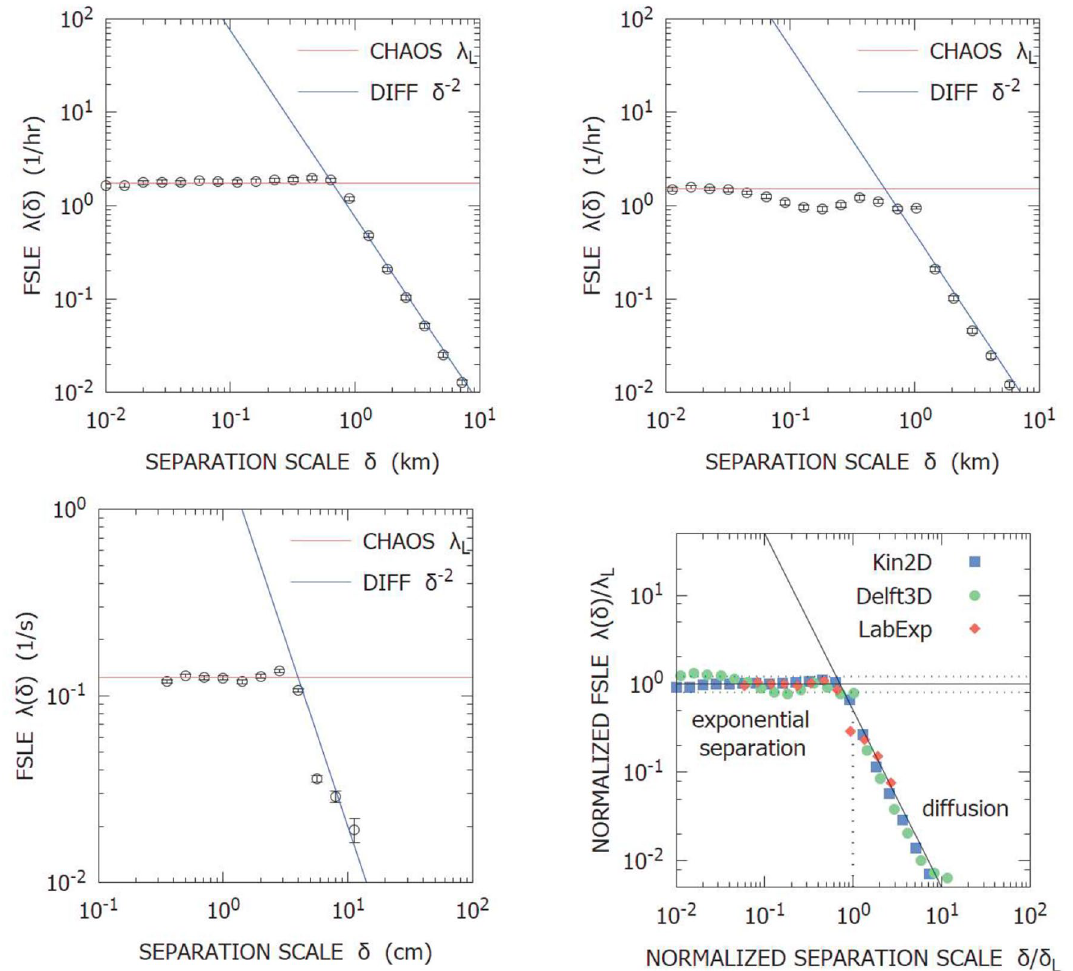
Figure 3. Finite-Scale Lyapunov Exponents: Kin2D (top left), Delft3D (top right), LabExp (bottom left) and overlap of all the renormalized functions (bottom right).